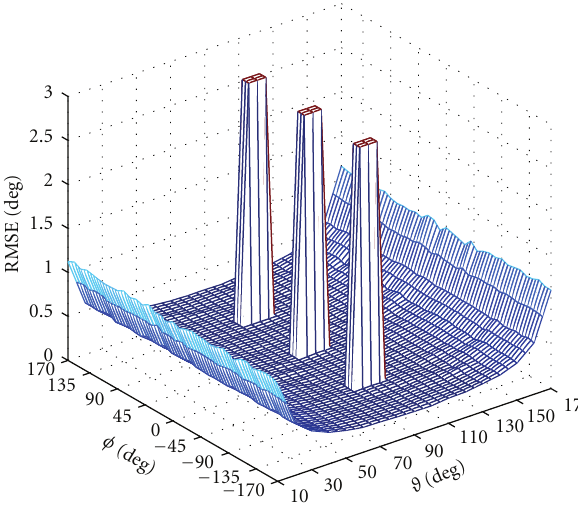
Figure 6: Aggregate RMSE as a function of azimuth and elevation